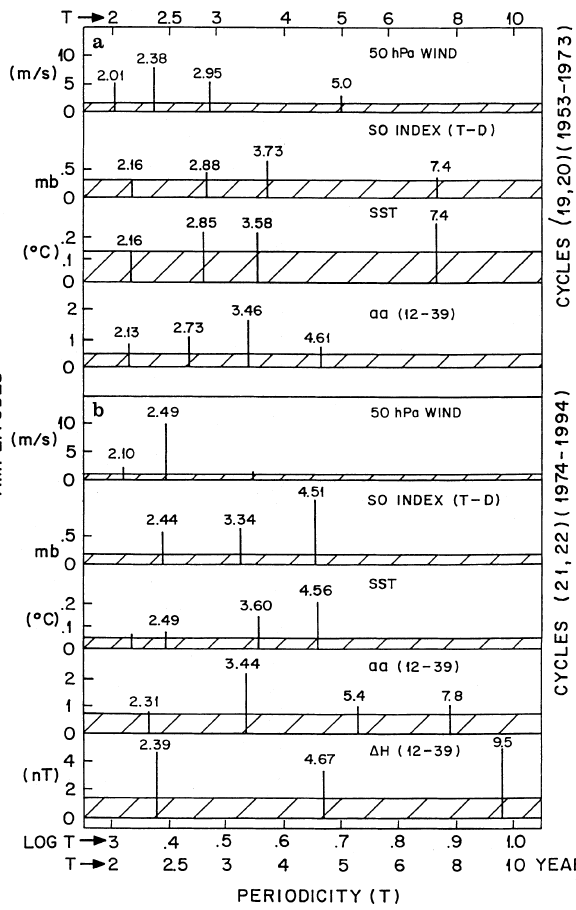
Fig. 12a,b. Spectra of the 12-monthly running mean series of 50 hPa wind , SO index (T-D) , SST and aa (12-39) for two consecutive 21- year intervals a 1953–1973 (cycles 19, 20, upper panel ) and b 1974– 1994 (cycles 21, 22, lower panel ). Here, (cid:68) H (12-39) is also shown, representing quiet day daily range of the geomagnetic H component at Trivandrum